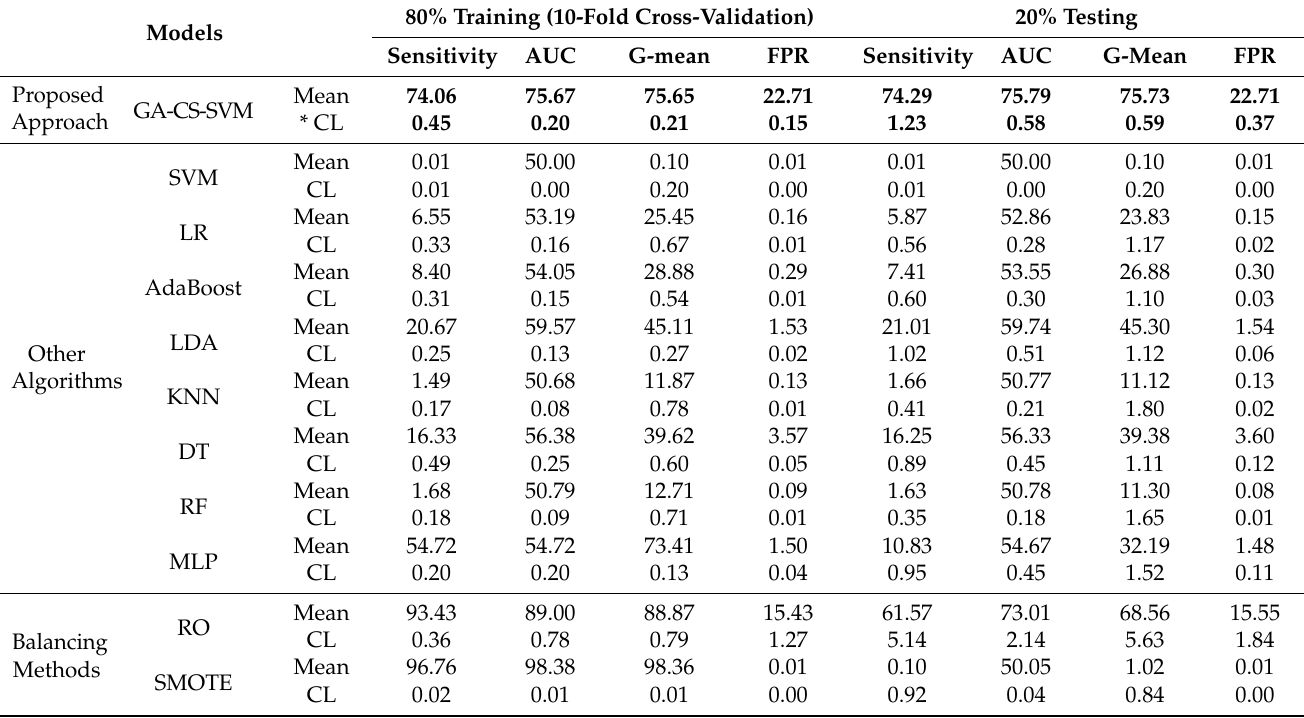
Table 3. Phase 1 results (training with 10-fold cross-validation and testing).